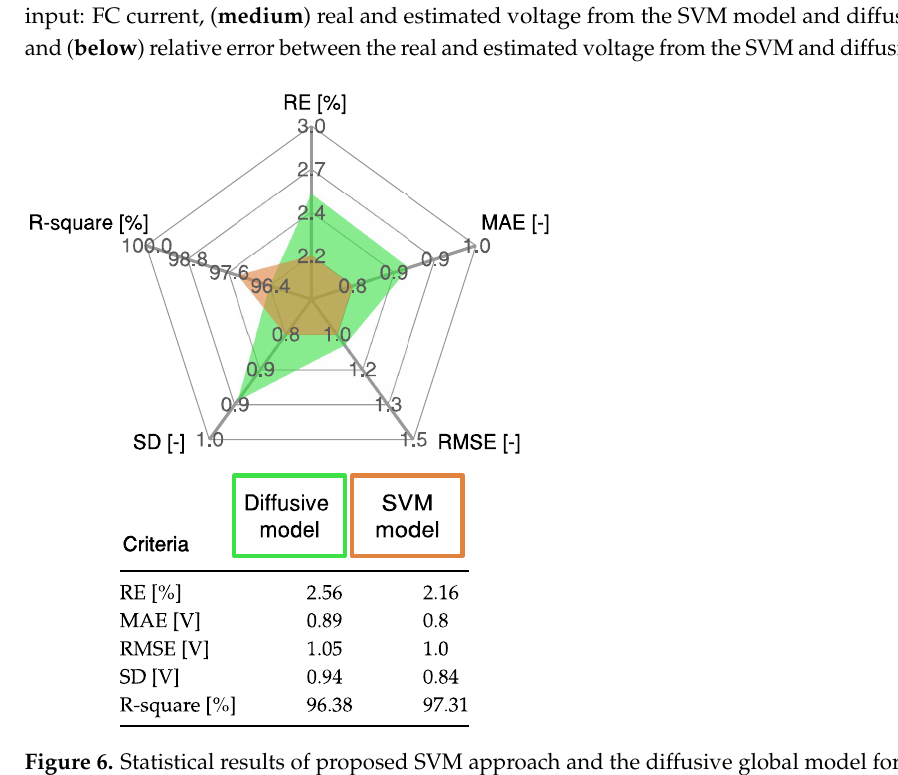
Figure 6. Statistical results of proposed SVM approach and the diffusive global model for the profile shown in Figure